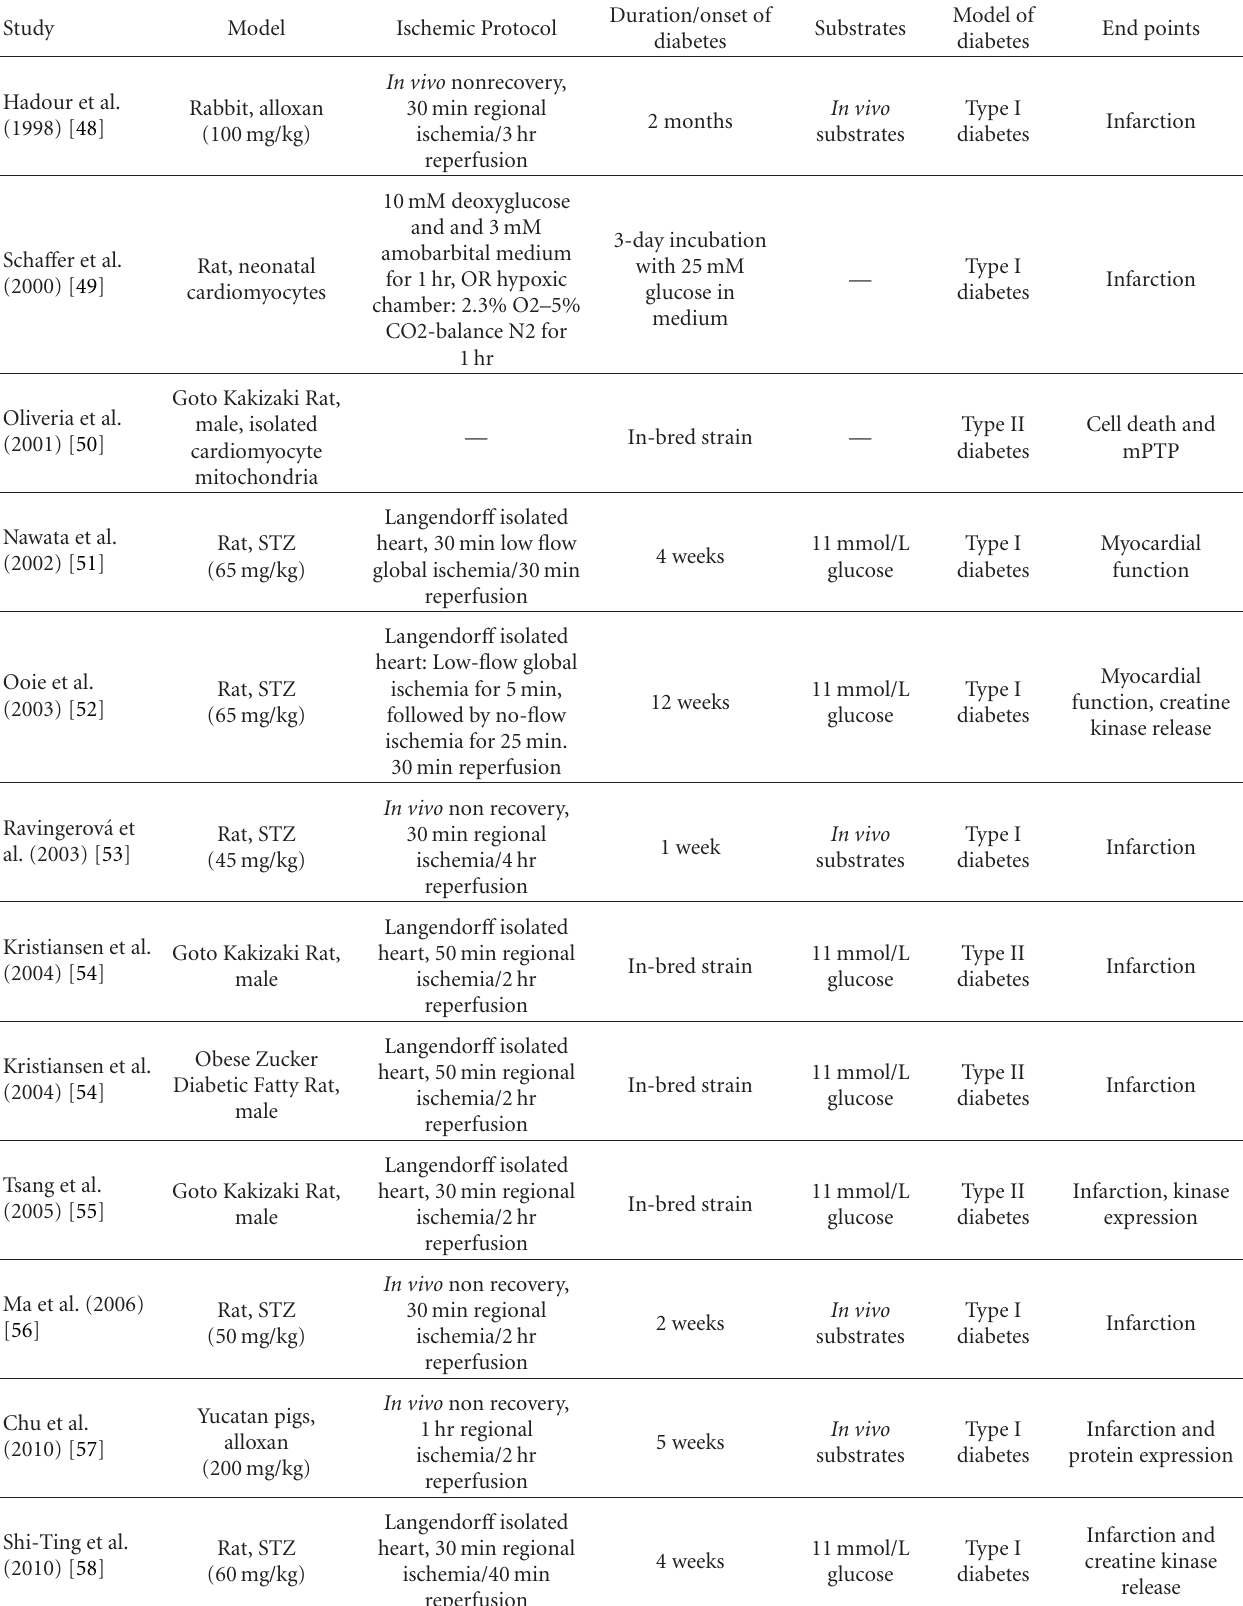
Table 2: Studies indicating the diabetic heart is less sensitive to ischemic injury compared to normoglycaemic controls. Study Hadour et al.